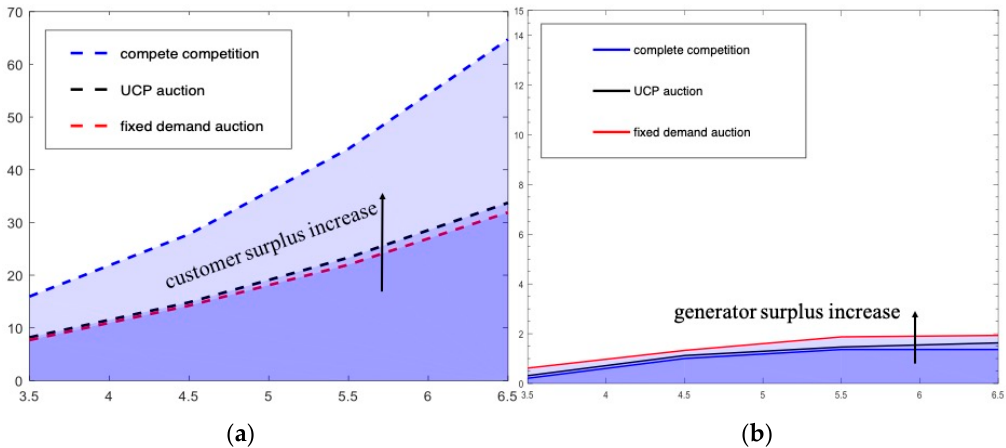
Figure 3. Demand scenario effected on social welfare: ( a ) customer surplus comparison; ( b ) generator surplus comparison.